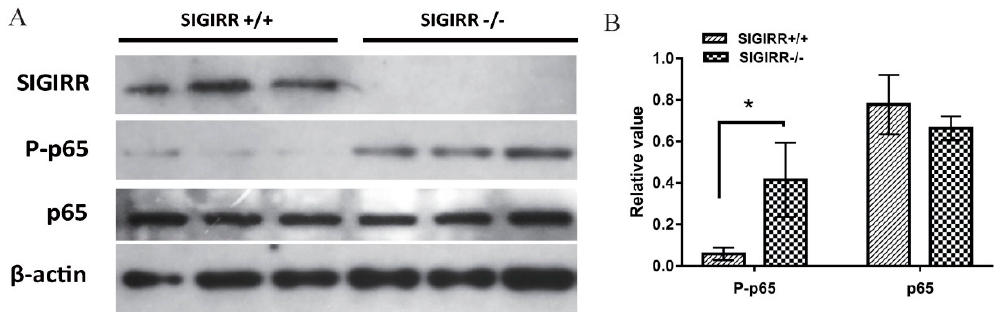
Figure 7. SIGIRR- / - cells have an increased NF- κ B activation compare with SIGIRR +/+ cells. SIGIRR- / - and SIGIRR +/+ 3D4 / 2 cells were infected with PCV2 at MOI of 1 for 12 h, and the SIGIRR, p-p65, and p65 expression were measured by Western blotting ( A ). Densitometric analysis was performed by Image J software and results were normalized to β -actin ( B ). Results are mean ± SE of three independent experiments. * p < 0.05.